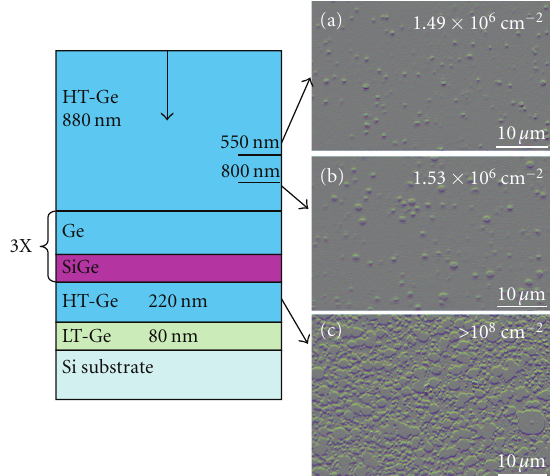
Figure 4: Schematic and optical images of the sample etched at various depths to reveal etch pit